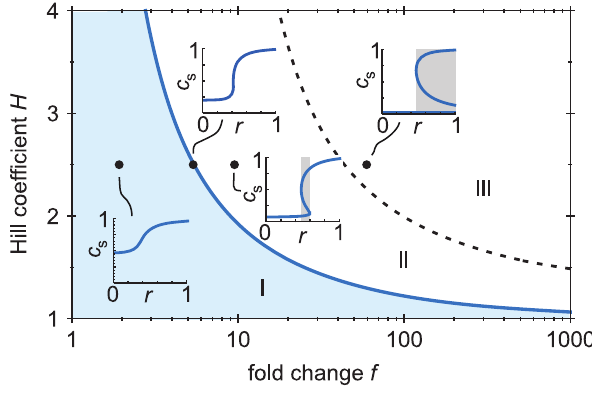
Figure 2. Phase diagram showing which parameter values lead to bistability. When the fold change and the Hill coefficient are both low (regime I), the response of the TF concentration is not bistable (see inset). Above the blue, solid line, however, bistability sets in for a range of input values r . Above the dotted line (regime III), the bistability remains even when the signal is saturated ( i.e. , if r ~ 1 ). Response circuits for which bistability and hysteresis are not desired, are restricted to the shaded parameter regime. (The blue line does not depend on other parameters; the dotted line depends on the ratio K = c max , here chosen to be 0 : 25